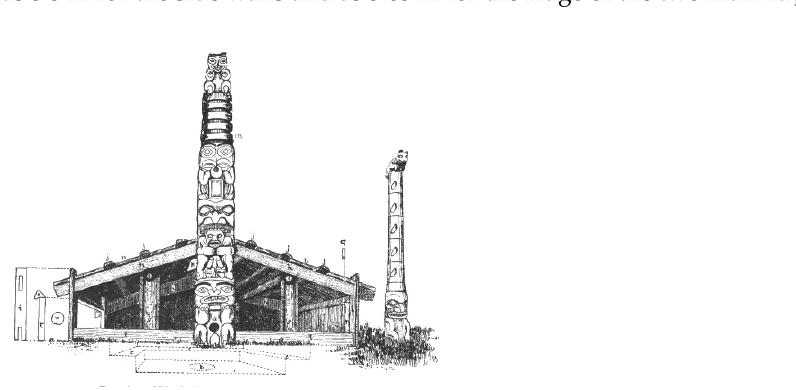
Figure 4. Cutaway section of Haida dwelling [13] (detail of plate XXXV).